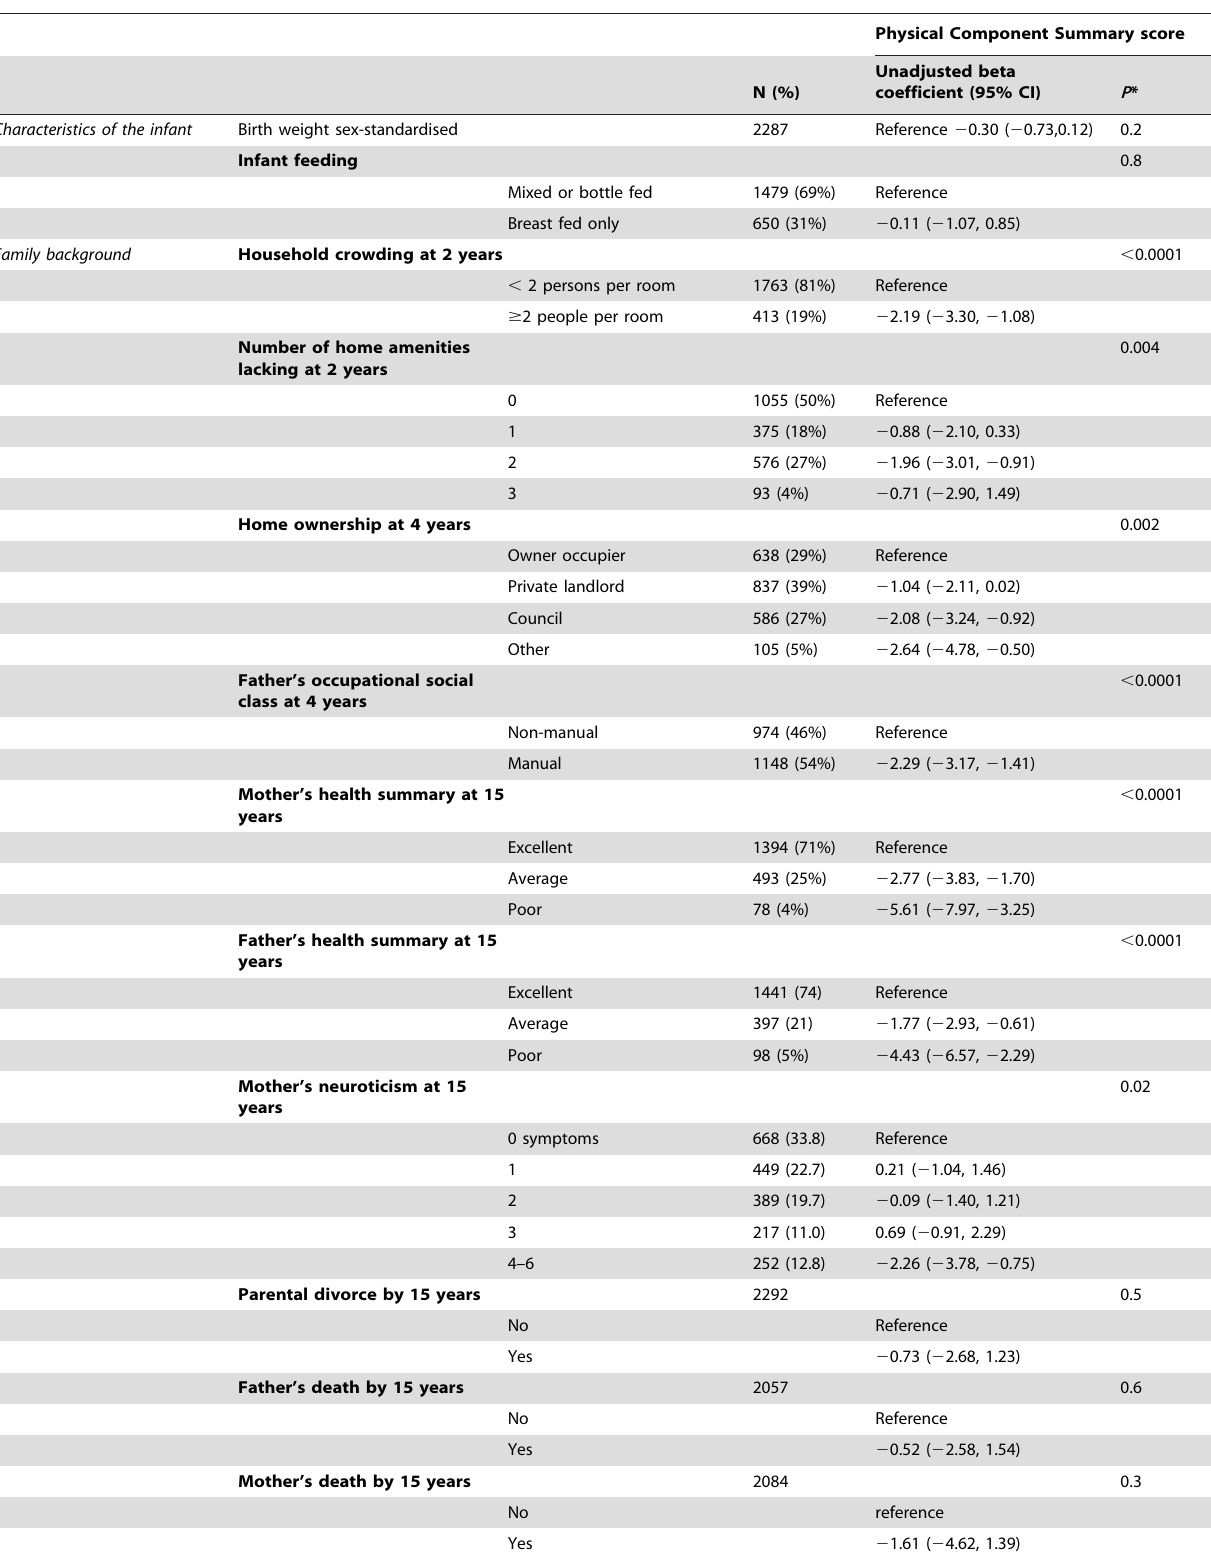
Table 2. Factors across the life course and physical component summary scores from the Short Form-36 at age 60–64